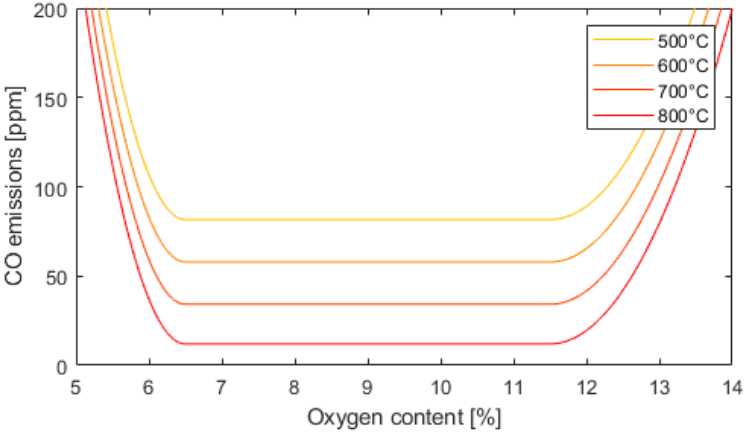
Figure 9. Average CO emissions as a function of the residual oxygen content for different temperatures in the combustion chamber.